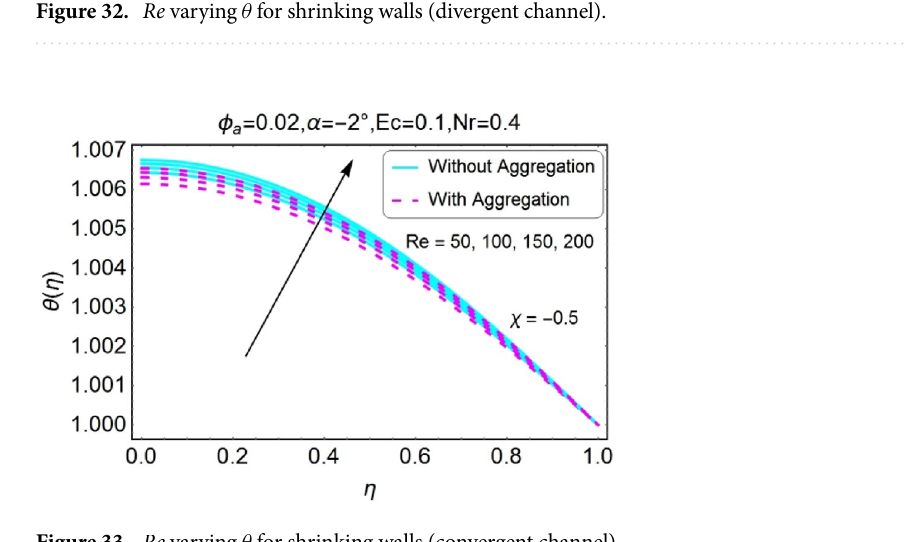
Figure 33. Re varying θ for shrinking walls (convergent